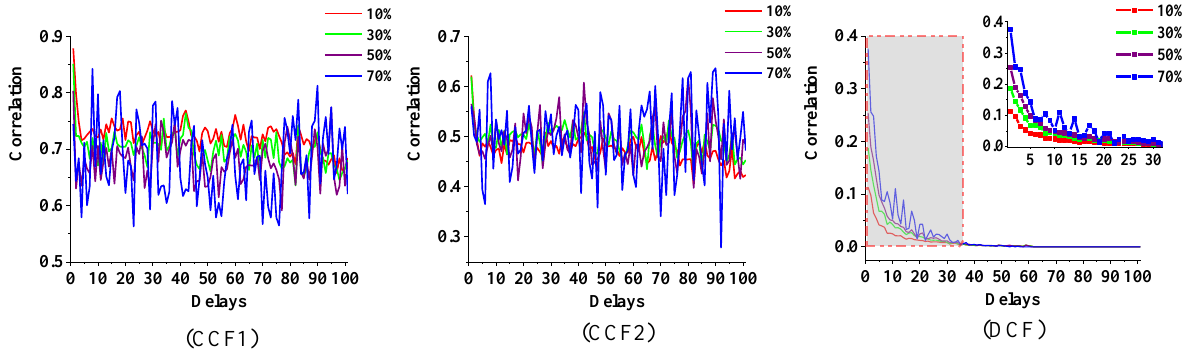
Figure 18. Relationship between the correlation and time delays for different non-vacant ratios.